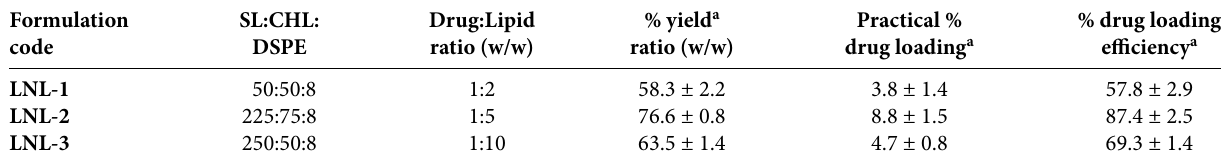
Table 1 . Formulation components, % yield, % drug loading and % drug loading efficiency of selected experimental formulations b